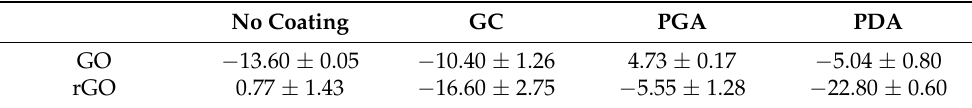
Table 2. Zeta potential values measured for GO and rGO in ethanol, with and without coatings.